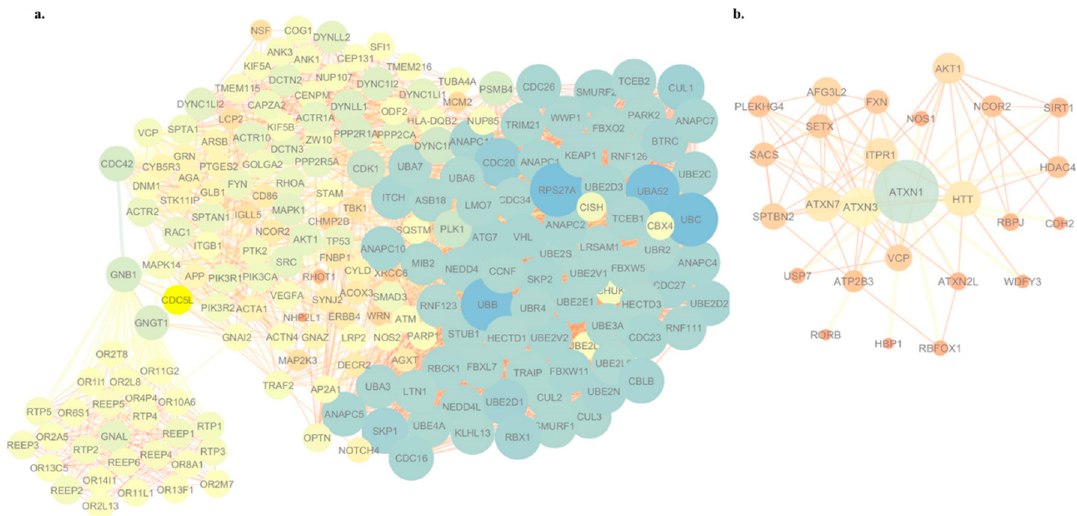
Figure 3. Integrative network analysis of the genetic variants in the ALS patient. ( a ) Protein–protein interaction (PPI) network of hub genes (degree ≥ 10) affected by rare missense mutations in the ALS patient. The node size was proportional to the degree and the edge width was proportional to the combined score based on the STRING database. Genes with higher degree values have a stronger capacity of modulating adjacent genes. ( b ) ATXN-1 -gene-centered subnetwork. The subnetwork includes most of the ATXN-1 -related genes involved in the Notch-specific miRNA-TF regulatory network. The node size was proportional to the degree, and the edge width was proportional to the combined score based on the STRING database.